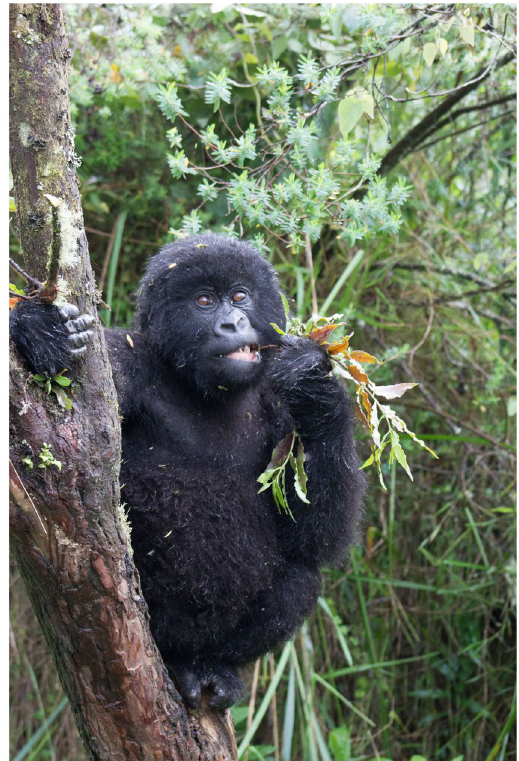
Figure 1. Infant Virunga mountain gorilla chewing and discarding plant pieces in the Volcanoes National Park,